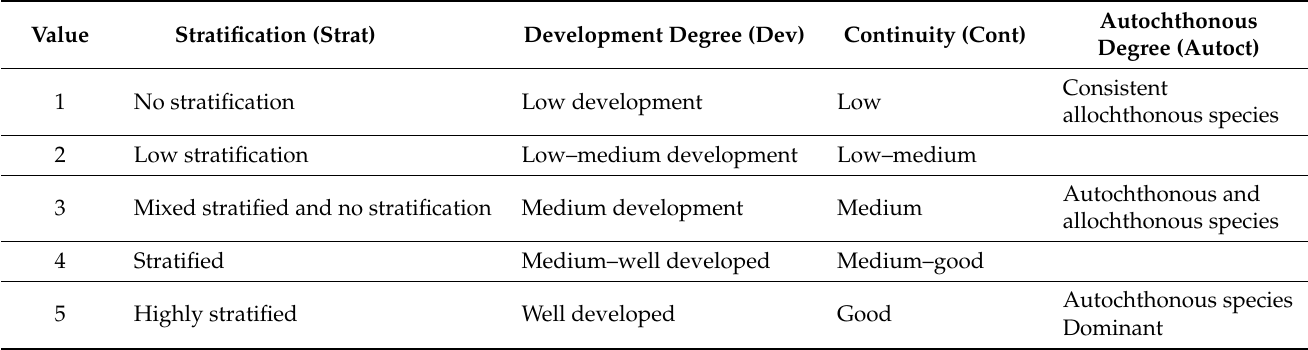
Table 1. The four criteria used for links’ Ecological Quality Classes